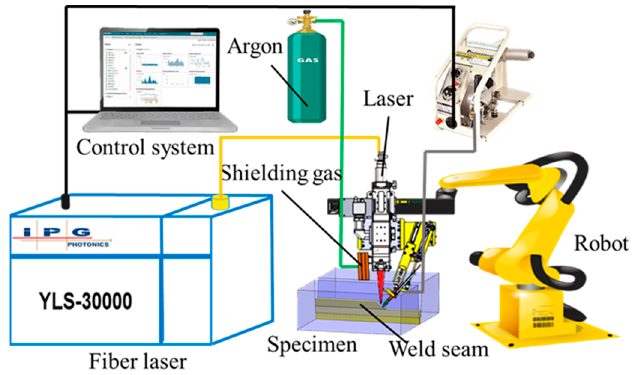
Figure 1. Laser-wire-filling welding system.